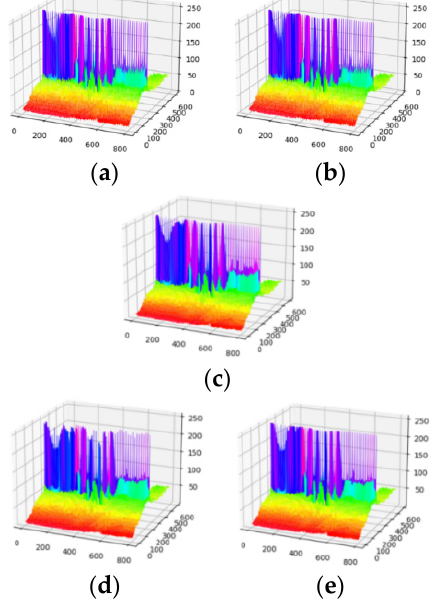
Figure 4. Comparison of three-dimensional gray-scale images based on preprocessing: ( a ) represents the original image, ( b ) represents Gaussian filtering and open operation, ( c ) represents Gaussian filtering and closed operation, ( d ) represents median filtering and open operation, ( e ) represents median filtering and closed operation.